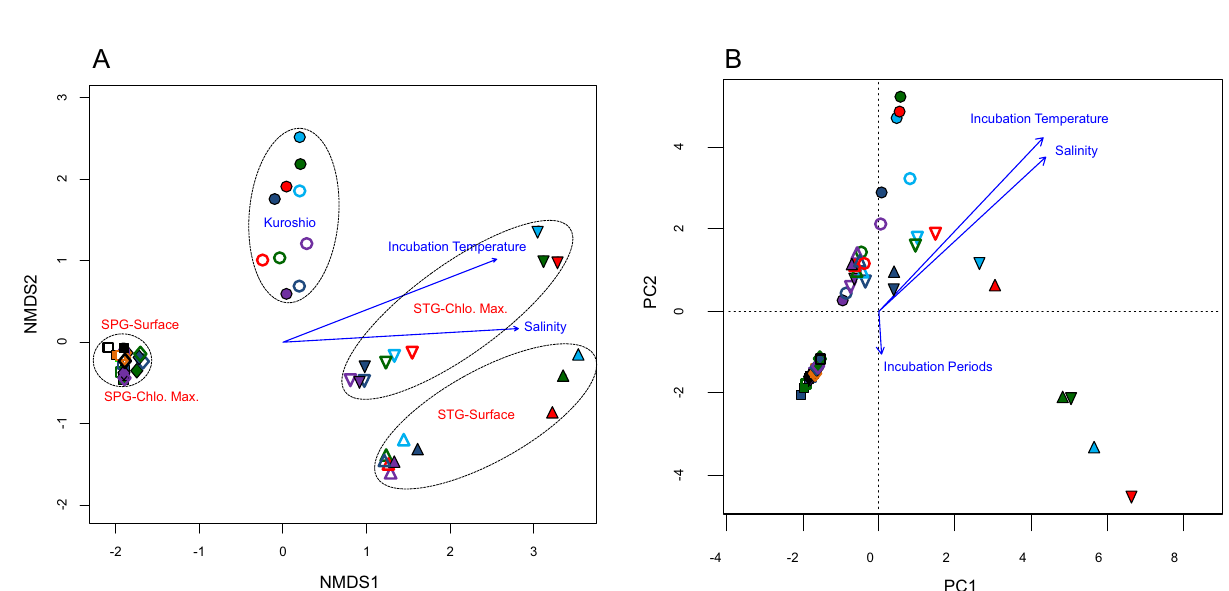
Figure 4. Non-metric Multidimensional Scaling (NMDS) and Redundancy Analysis (RDA) showing the relationship between environmental factors, incubation conditions (periods and temperatures), glucose treatment (treated and control), and bacterial community structure for different sampling stations; Kuroshio Current, North Pacific Sub-polar Gyre (SPG-surface, and SPG-chlorophyll maximum), and North Pacific Sub-tropical Gyre (STG-surface and SPG-chlorophyll maximum). Seawater samples of Kuroshio Current, SPG-surface, SPG-chlorophyll maximum, STG-surface water, and STG-chlorophyll maximum are presented respectively by symbols circle, square, diamond, triangle, and inverted triangle; symbols in purple, dark blue, red, green, light blue, orange, and black indicating incubation periods of 12 h, 24 h, 36 h, 48 h, 60 h, 72 h, and 96 h, respectively; filled symbols are for treated and unfilled symbols are for control